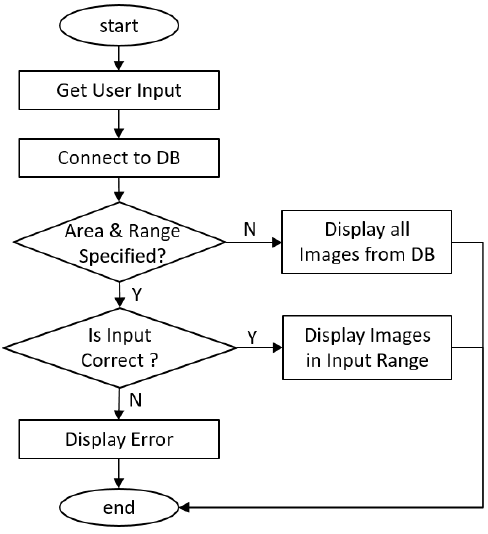
Figure 9. Simplified flowchart of monitoring software.